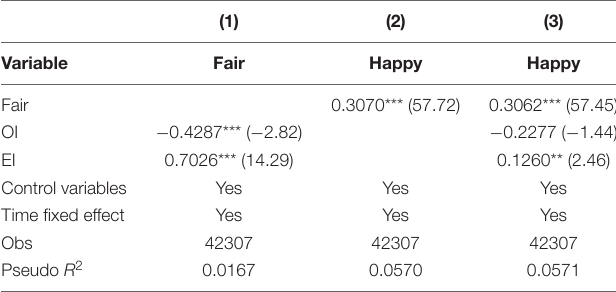
TABLE 6 | The results of influencing